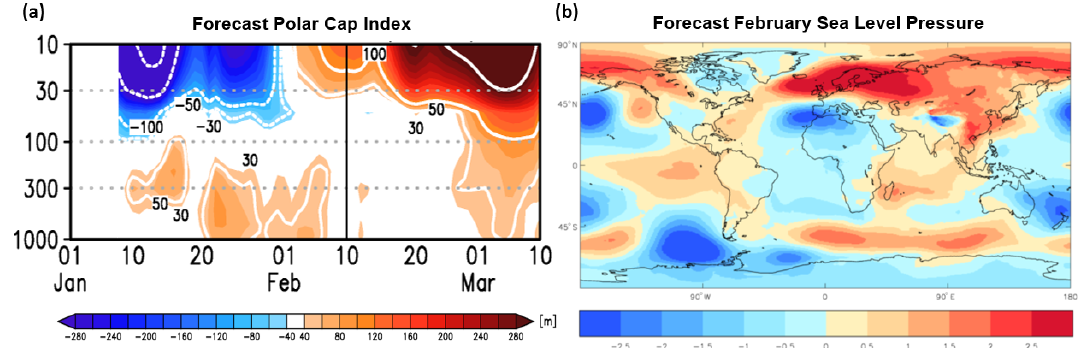
Figure 2. Monthly forecasts prior to the 2018 sudden stratospheric warming and severe cold event over northern Europe. Forecast polar cap index (a) and February sea level pressure anomalies (b) . Ensemble mean anomalies are shown for the average of forecasts initialized between 8 and 22 January 2018 relative to hindcasts over the 1993–2016 period using the Met Office Hadley Centre GloSea (global seasonal) prediction system (MacLachlan et al., 2015). Sea level pressure is measured in hectopascals (hPa), and the polar cap index is the geopotential height anomaly (m) averaged over 65 ◦ N to the North